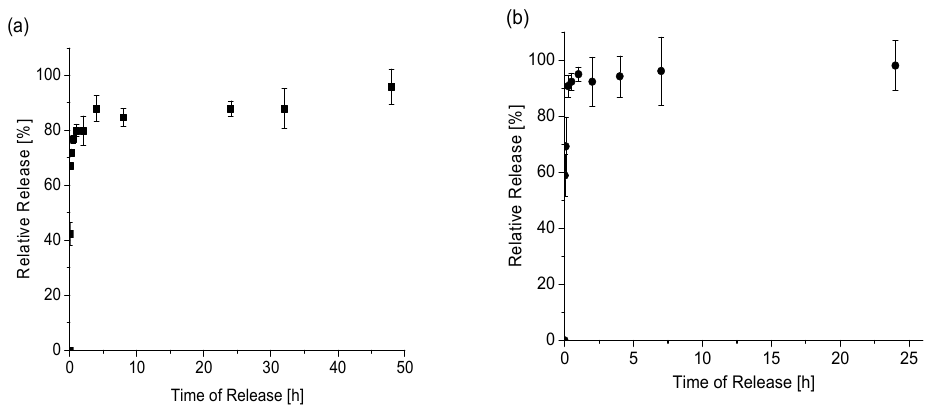
Figure 8. The relative release profile of DSS loaded into the electrospun CSF fibers with 15% w / w of DSS ( a ) and 30% w / w of DSS ( b ). Relative release was measured in triplicate from two independent release experiments.